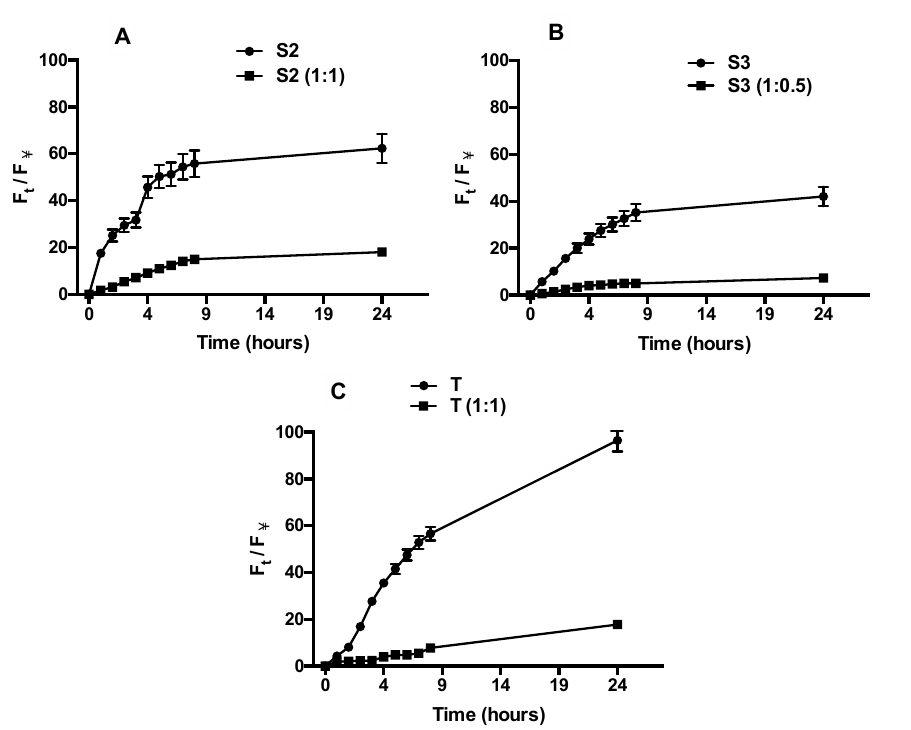
Figure 7. Release profile of calcein by uncoated and HA-Chol-coated Span (panel ( A ) S2; Panel ( B ) S3) and Tween (Panel ( C ) T) niosomes expressed as fluorescence percentage of calcein released.